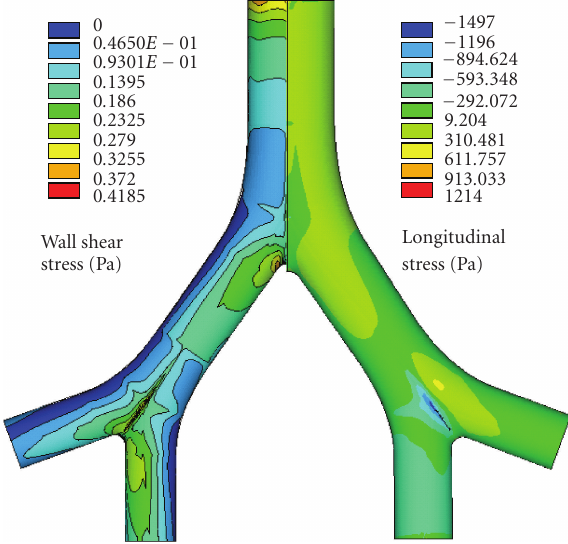
Figure 7: A distribution of the wall shear stress (WSS) and longitudinal stress in the airway generations 3 to 5 for the orthotropic flexible model during the peak